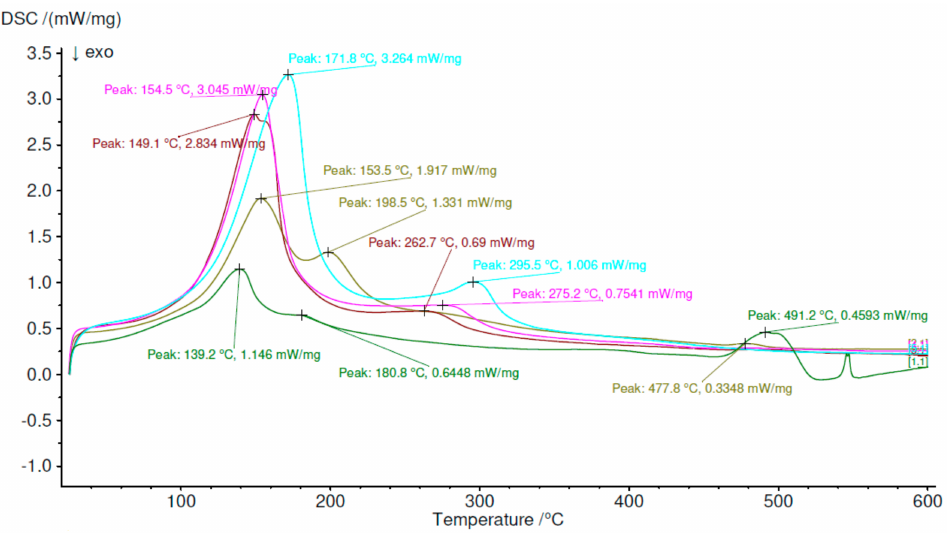
Figure 5. Di ff erential scanning calorimetry results. Table 8. DSC